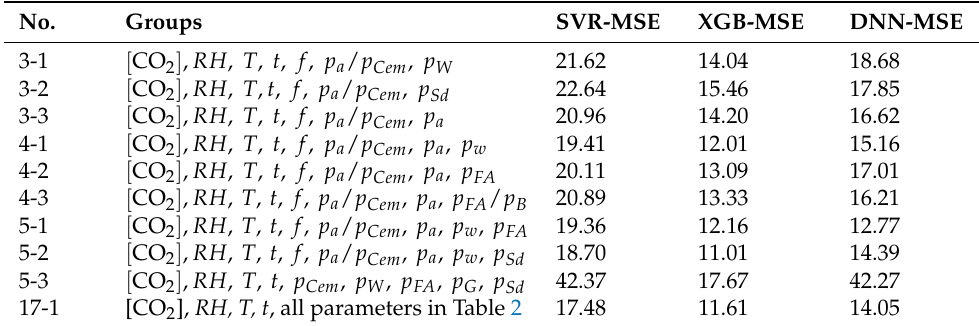
Figure 6. Illustration of 5-fold cross-validation. Table 4. Verification of combinations.